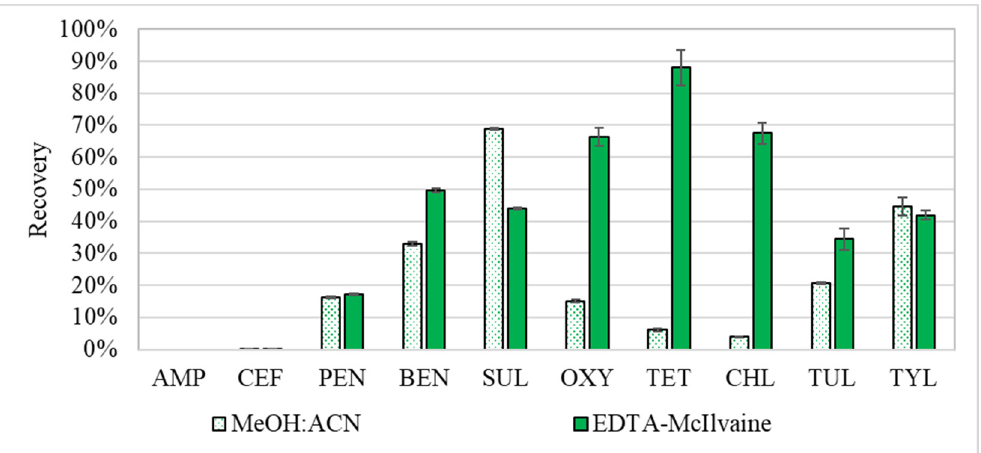
Figure 1. Recoveries from extraction of spiked manure with either EDTA McIlvaine buffer (solid bar) or 50:50 MeOH:ACN (the dotted bar). Recoveries are treatment averages ( n = 3), with error bars based on ± standard error. The antibiotics examined include Ampicillin (AMP), Ceftiofur (CEF), Penicillin-G (PEN), Benzylpenicilloic Acid (BEN), Sulfadimethoxine (SUL), Oxytetracycline (OXY), Tetracycline (TET), Chlortetracycline (CHL), Tulathromycin-A (TUL), and Tylosin Tartrate (TYL). Table 1. Select physiochemical properties and analytical method parameters of antibiotics inves- tigated in this study, including their chromatographic retention times (RT).